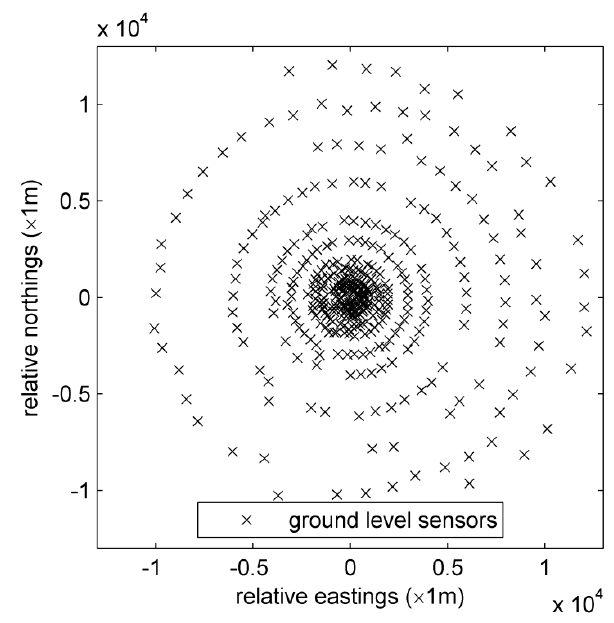
Figure 1. Distribution of ground-level concentration monitoring sensors.